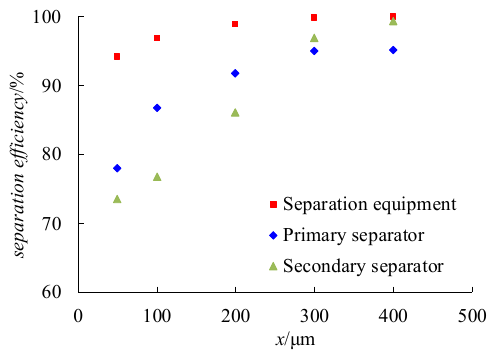
Figure 3. Separation efficiency of separation equipment and each separator.